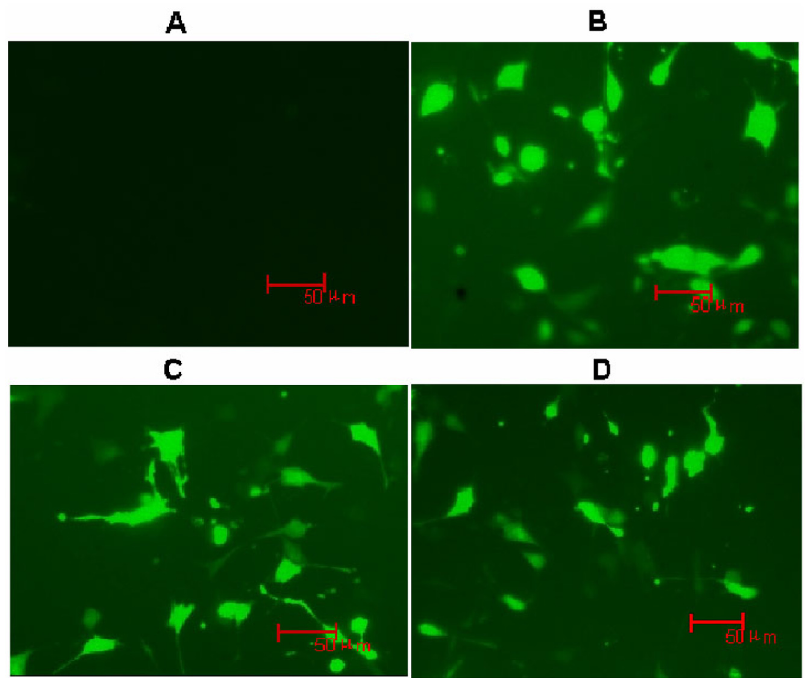
Figure 3. Fluorescence profiles of hepatic stellate cells (HSCs) transfected with three dif- ferent siRNA vectors labeled with green fluorescent protein (GFP). A , Normal HSCs; B - D , HSCs transfected with three different Smad3 siRNA expression vectors at 1.0 µg plas- mids/10 6 cells. The expression of GFP in Panel C (SD1211-SiSmad3-2) is powerful and is the best Smad3 siRNA expression vector in this study.